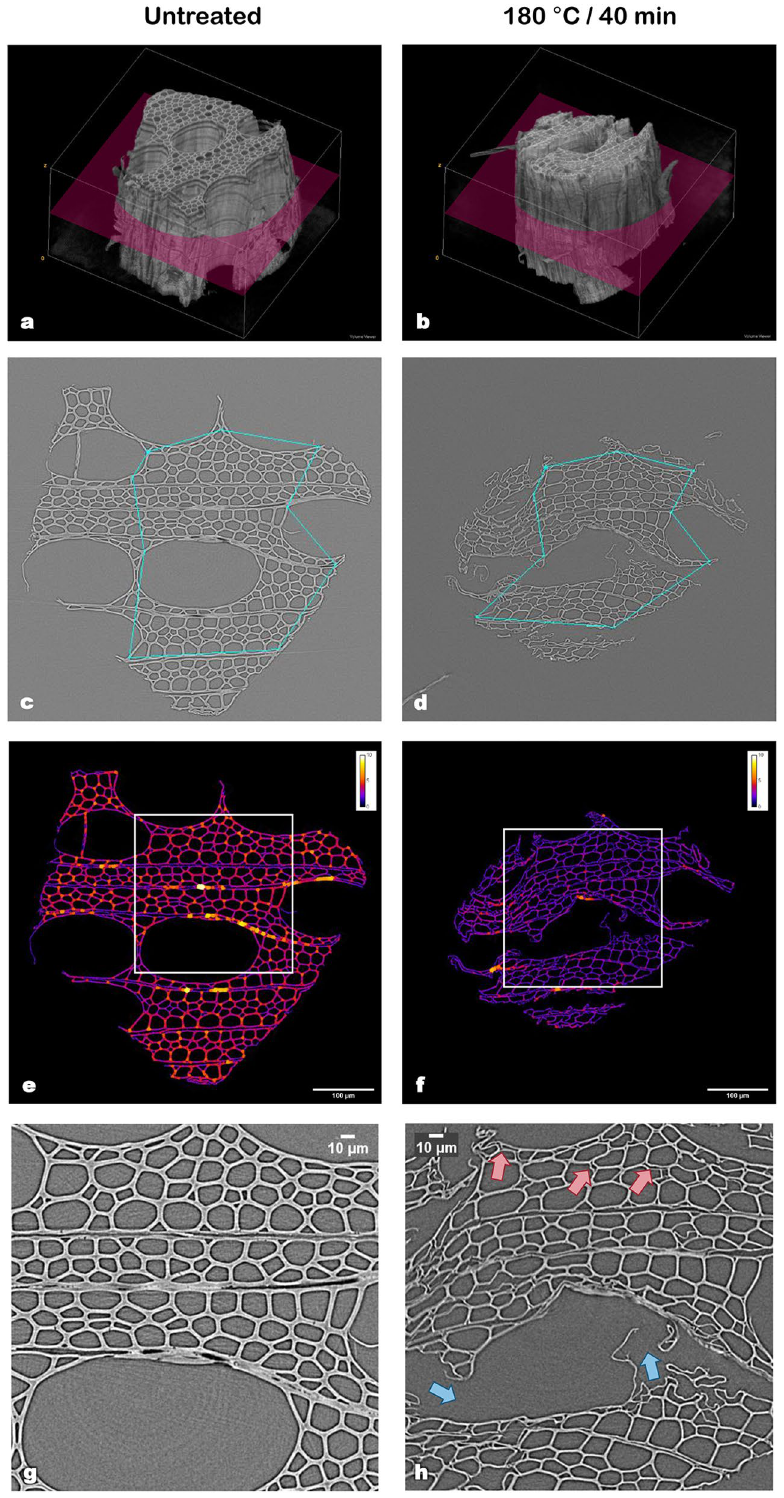
Figure 6. X-ray nano-tomography images of the same sample in its untreated state and after hydrothermal treatment at 180 °C for 40 min. ( a , b ) 3-D reconstructions of the sample, highlighting the virtual sections observed in figures ( c – h ) [obtained with the help of ImageJ v1.52i software; imagej.nih.gov/ij/]. ( c , d ) The chains of points used to determine the shrinkage of the sample. ( e , f ) The calculated thickness of cell walls throughout the slices (in µm) [obtained with the help of ImageJ v1.52i software; imagej.nih.gov/ij/]. ( g , h ) Highlights of vessel disruption (blue) and cell detachment (red), extracted from the regions within the white rectangles in ( e , f